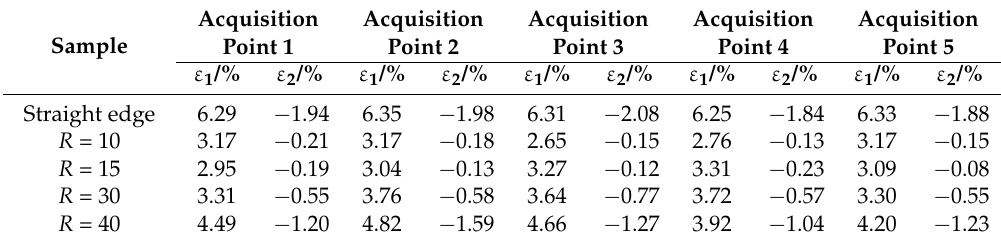
Table 4. Strain state of critical orange peel structure of specimens under different strain paths.